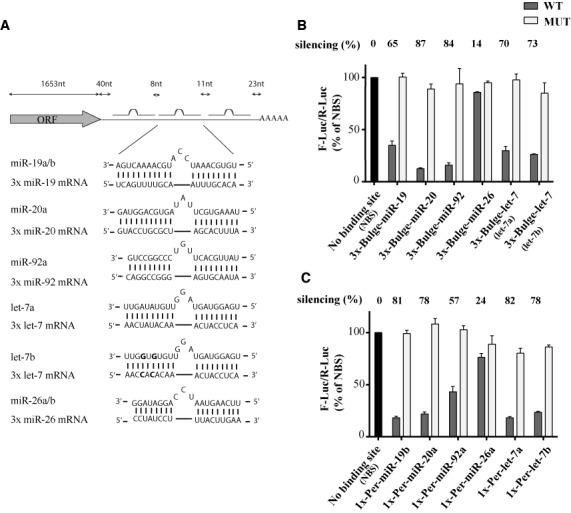
Comparative slicing and slicing-independent silencing by miRNA families. (A) Schematic representation of 3x-Bulge Firefly luciferase (F-Luc) silencing reporters. The structures of mismatched (Bulge) sites are described. Spacing and positioning of sites is the same for all reporters [though miR-26 reporter has a minor disparity] (See Supplementary Table S1). Mutated (MUT) reporters encode an additional 3-nt mutation in seed-complementary sequences (See ‘Materials and Methods’ section). Differences between the let-7a and let-7b-based reporters are highlighted in bold. (B) HEK 293T cells were co-transfected with constructs expressing WT or MUT sites (as indicated) for miR-19, miR-92, miR-20, miR-26 or let-7, and Renilla luciferase (R-Luc) as an internal standard. Normalized counts are compared to the no binding site reporter (NBS), which is set as 100% for comparison. (C) Similar analyses were conducted with reporters expressing one perfectly matching site for each examined miRNA. All data are presented as mean ± standard deviation from technical triplicates of three independent biological experiments.